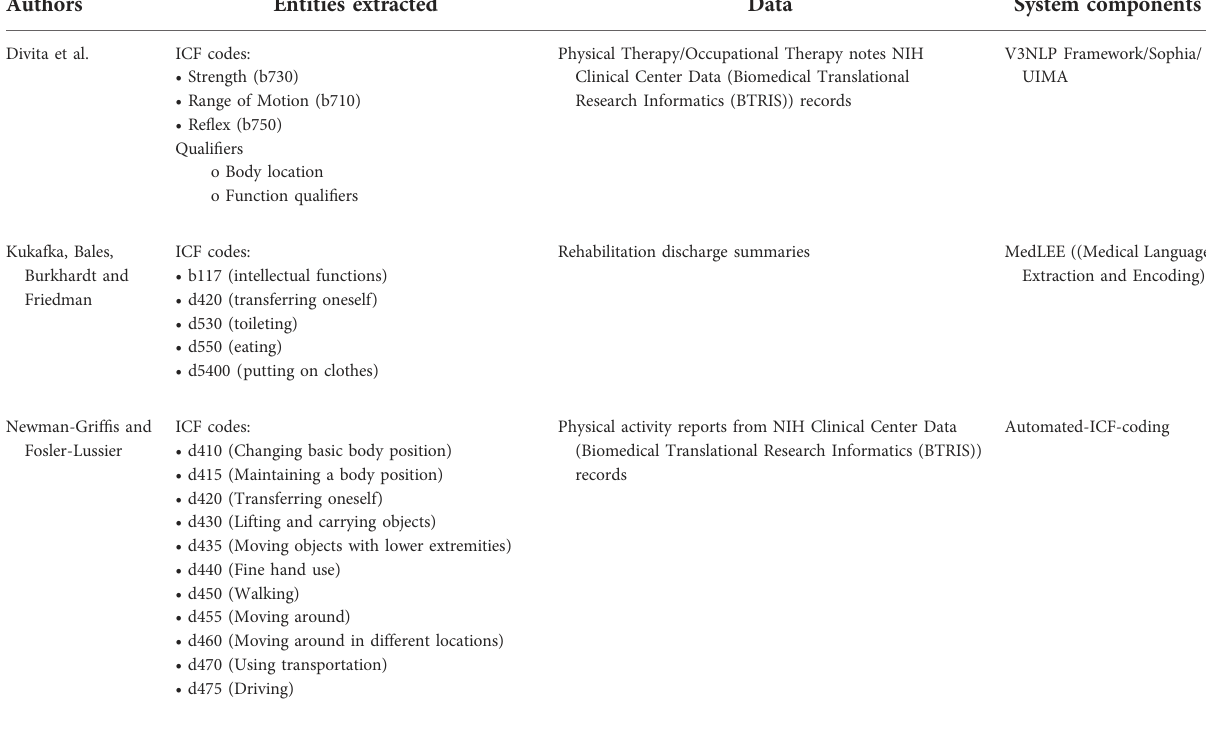
TABLE 1 Prior work extracting ICF